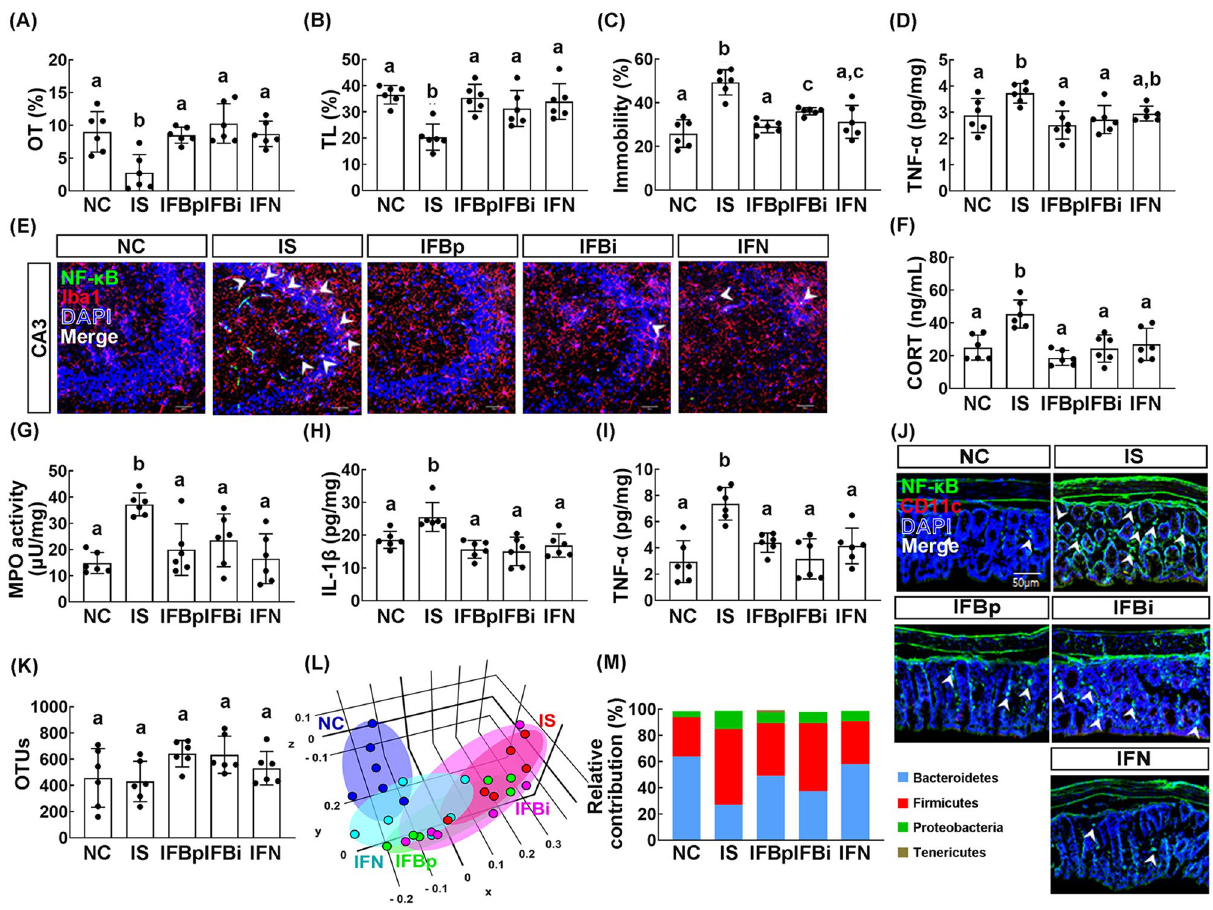
Figure 6. Fecal transplantation of buspirone/immobilization stress (IS)-treated mouse feces or untreated control mouse feces alleviated immobilization stress-induced anxiety/depression, colitis, and gut microbiota pertubation in the transplanted mice. Effects on IS-induced anxiety/depression-like behaviors in EPM task ( A , OT), LDT ( B , TL), and TST ( C ). Effects on TNF-α expression ( D ) and NF-κB + /Iba1 + cell population ( E ) in the hippocampus. Effect on corticosterone (CORT) level ( F ) in the blood. Effects on IS-induced myeloperoxidase (MPO) activity ( G ), IL-1β ( H ) and TNF-α expression ( I ), and NF-κB + /CD11c + cell population ( J ) in the colon. Effects on the composition of gut microbiota: OTUs ( K ), principal coordinate analysis (PCoA) plot ( L ), and phylum ( M ). IFN, IFBp, and IFBi groups were orally gavaged with the feces of normal mice (FN), orally buspirone-gavaged mice with IS (FBp), and intraperitoneally buspirone-injected mice with IS (FBi) daily for 5 days from the next day after the final exposure to IS. A IS group was treated with vehicle (saline) in IS-exposed mice instead of fecal suspensions. Normal control mice (NC) was orally treated with vehicle (saline) instead of the fecal suspension. The present fecal microbiota compositions of NC and IS groups were shared in Fig. 2. ( L ) was created in the free Plotly Make Chart program (https ://chart -studi o.plotl y.com/creat e/#/). Data values were indicated as mean ± SD (n = 6). Same alphabets are not significantly different ( p < Figs. S8, S9). FBi transplantation reduced IS-induced Helicobacteriaceae and Ruminococeae populations at the family level, Helicobacter, Oscillibacter and PAC000664_g populations at the genus level, Helicobacter rodentium group and PAC002027_s populations at the species level and increased IS-suppressed Muribaculaceae population at the family, Alistipes and PAC001068_g PAC000664_g populations at the genus level, and AB599946_s and PAC002445_s at the species level. FN transplantation reduced IS-induced Helicobacteriaceae, Lachnospiraceae, and Ruminococaceae populations at the family level, LLKB_g, Oscillibacter, PAC000664_g and Pseudoflavoni- fractor populations at the genus level, and Helicobacter rodentium group and PAC001083_s population at the species level and increased IS-suppressed Bacteroidaceae Muribaculaceae populations at the family, Alistipes population at the genus level, and EF097112_s and PAC002445_s at the species level.